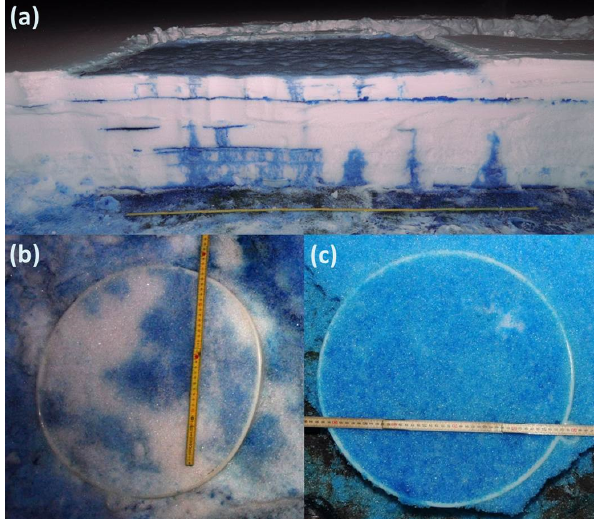
Figure 1. (a) Vertical cut of a snowpack after the sprinkling ex- periment Sertig Ex3 (28 February 2015). Lateral flow and the pres- ence of PFP were observed. PFP were generated at regions with rain water ponding at ice layers and layer boundaries with a change in grain size (creating capillary barriers). (b) Lysimeter area af- ter sprinkling during winter conditions (Serneus Ex1, 26 Febru- ary 2015): coloured areas indicate the area where water percolated due to PF. (c) Lysimeter area after sprinkling during spring con- ditions (Klosters Ex4, 26 March 2015): coloured area shows that water percolated uniformly, indicating dominating matrix flow.